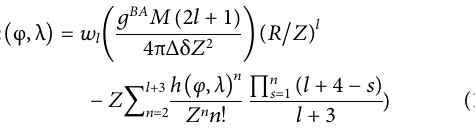
FIGURE 2 Bouguer gravity anomaly of the mare